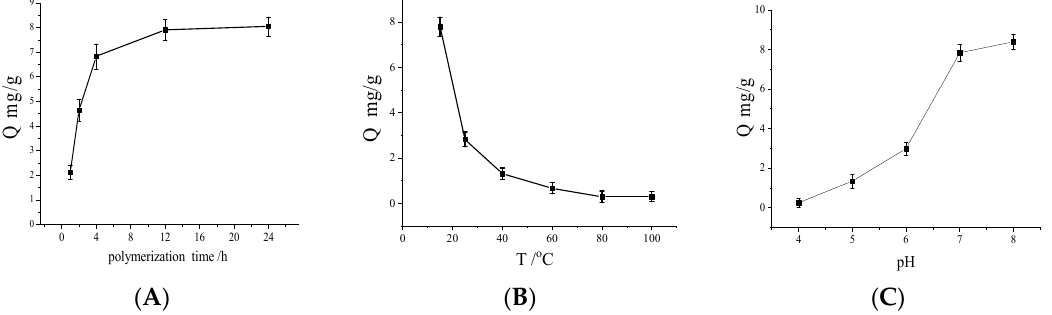
Figure 7. Adsorption mass of Cu(II) changed with DA polymerization time ( A ); temperature ( B ); pH ( C ). V = 1.0 mL, m = 3.0 mg, C i = 1.0 mmol/L, time 2 h.